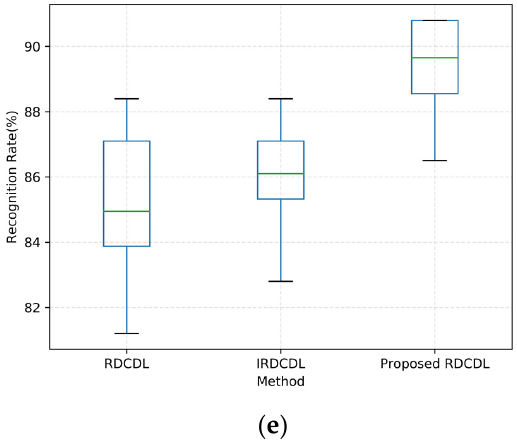
Figure 8. ( a ) Comparison of different KSVD algorithms; ( b ) Comparison of different DSVD algorithms. ( c ) Comparison of different LC-KSVD algorithms; ( d ) Comparison of different FDDL algorithms; ( e ) Comparison of different RDCDL algorithms. The accuracy of image classification increases steadily with the increase of atomic number. Compared with other algorithms, the proposed algorithm generally has advantages. Table 3. Average accuracy (%) on the AR face database.